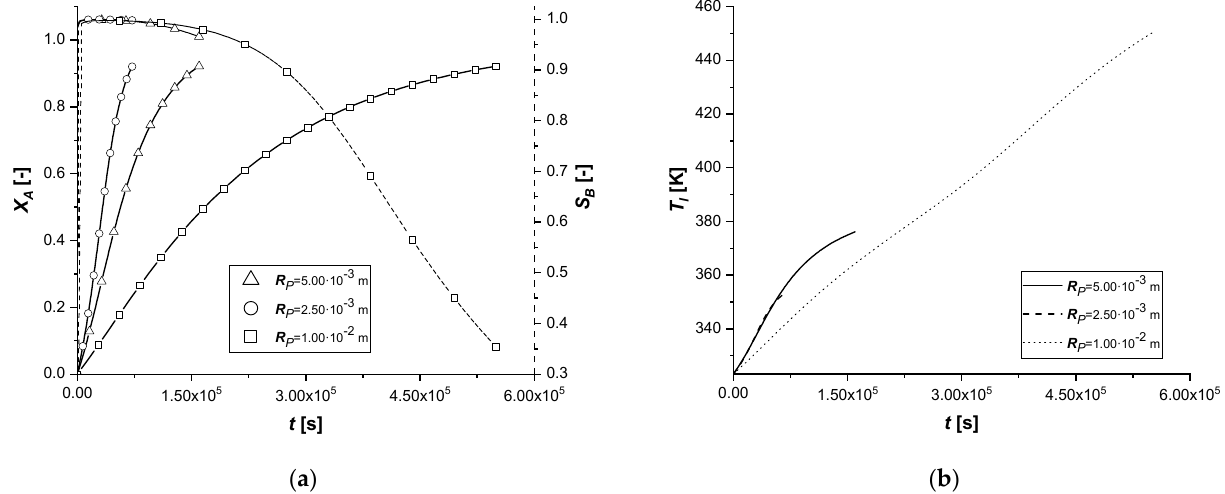
Figure 22. EY R P investigation. ( a ) Bulk profiles over time of X A and S B . ( b ) Bulk profile of T l over time. Observing the results in the comparison graphs, it can be stated that the response of the model to the variation of R P is opposite to what is visible in the simulations involving D eff,A . It is important to remember that, unlike the previous case, where the effect was fo- cused only on the main reacting species, in these simulations, the effect is related to all the species involved. In particular, a reduction of the particle size favors the diffusion of the reagent inside it and of the products towards the bulk. This result can be visualized very well due to the short reaction times. With a small radius, the quantity c Bl obtained in all cases is very high to the detriment of the by-product. If the particle size increases, the limitation caused by diffusive internal phenomena becomes even more dominant. In all the cases, a significant increase in the concentration of C is observed. This phenomenon is caused by the difficulty of B, once formed in the catalytic zone, to diffuse backward, accumulating in the solid and promoting the second reaction. The influence of R P in the liquid side balance is less evident than that observed in the solid side, being the external diffusive term much less sensitive to its small alterations. It can be assumed that the use of catalysts with a small particle radius favors the production of the reaction intermediate. 3.2.5. Catalyst Bulk Density The consequent alteration of ρ P , for the same particle radius, consists in a modifica- tion of the mass of catalyst present in the reactive system. This parameter directly affects the generative terms of intraparticle mass and energy balances. Finally, it also intervenes in the liquid side mass balance in the term ε . The comparison between the solid side and liquid side concentration profiles calcu- lated for all the catalytic cases are reported in Supplementary Materials in Figures S55– S63. The details of each conversion, selectivity, and liquid side temperature profiles, cal- culated for all catalytic cases, are shown in Figures 23–25.